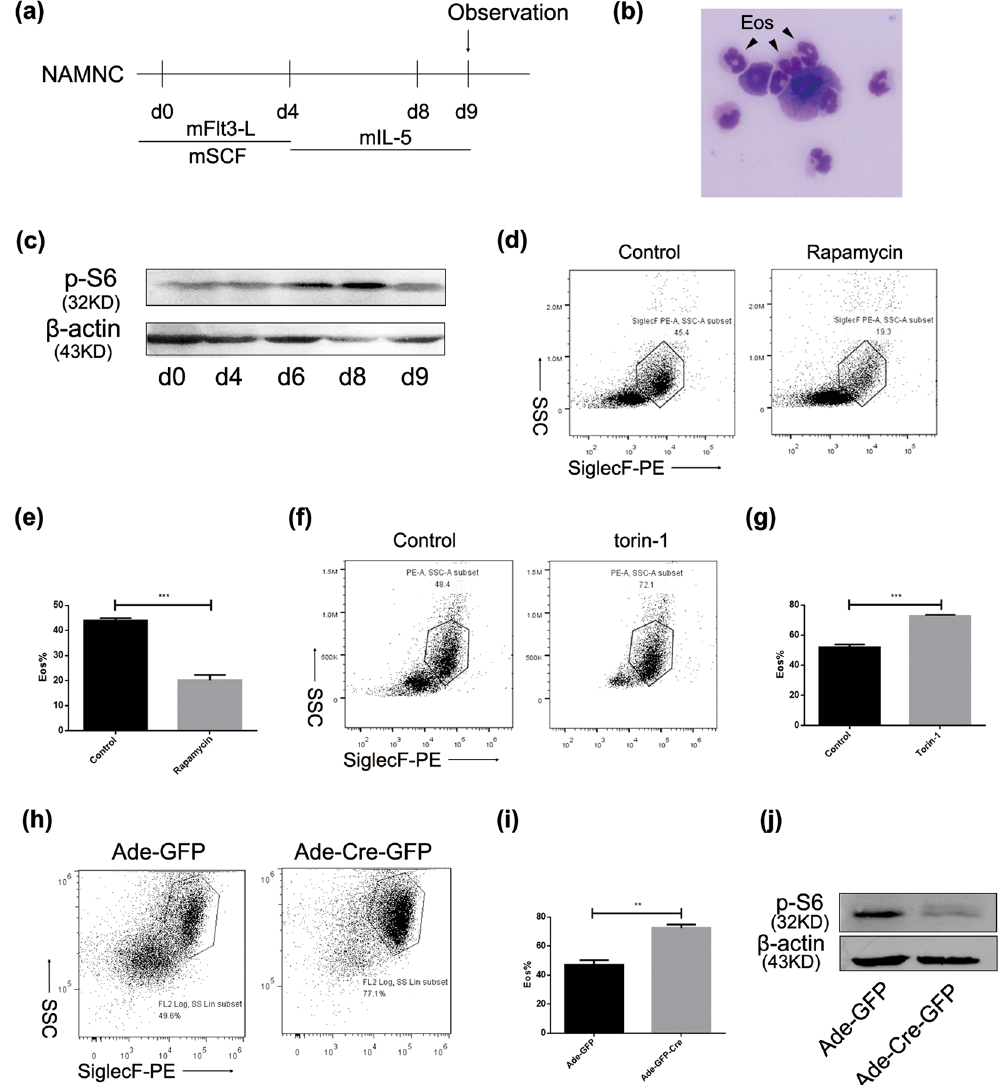
Figure 1. Torin-1 administration and genetic deletion of mTOR contributes to elevated differentiation of eosinophils. ( a ) Bone-marrow derived eosinophils (BMDE) during culture processes were harvested and mTOR (displayed as p-S6) was detected by western blot assay. ( b ) BMDE culture in vitro . Non-adherent mononuclear cells from bone marrow were obtained and differentiation was conducted with rmFlt-3L, rmSCF, and rmIL-5. Western Blot are performed according to auto-exposure and the resolution of 169 μ m. Given that the highest level of p-S6 expression was on day 8, torin-1 or rapamycin was treated on day 8. ( c ) Blots were cropped from the same gel.) Mature eosinophils underwent Wrights-Giemsa staining after being cytospined. Images were acquired from an Olympus BX51 microscope (x4/0.3 NA objective with Olympus DP70 digital camera) for acquisition of images. ( d , e ) Percentage of eosinophils after rapamycin treatment (50 nM) was detected by flow cytometry (d) and statistically analysed as means ± SEM using Student’s T-test (e). ( f , g ) Percentage (g) of eosinophils after torin-1 administration (250 nM) was detected by flow cytometry and statistically analysed as means ± SEM (g). ( h , i ) Adenovirus with Cre recombinase was harvested from HEK293T cells and the titer measurement was undertaken. Bone-marrow-derived cells were infected with adenoviral administration 6 hours without serum. Percentage (h) of eosinophils was detected by flow cytometry and statistically analysed as means ± SEM (i). All the results above were triplicated by three independent experiments. Efficiency of adenoviral knockdown ( j ) Blots were according to different gels.) was detected on day 9. * P < 0.05, ** P < 0.01, *** P <